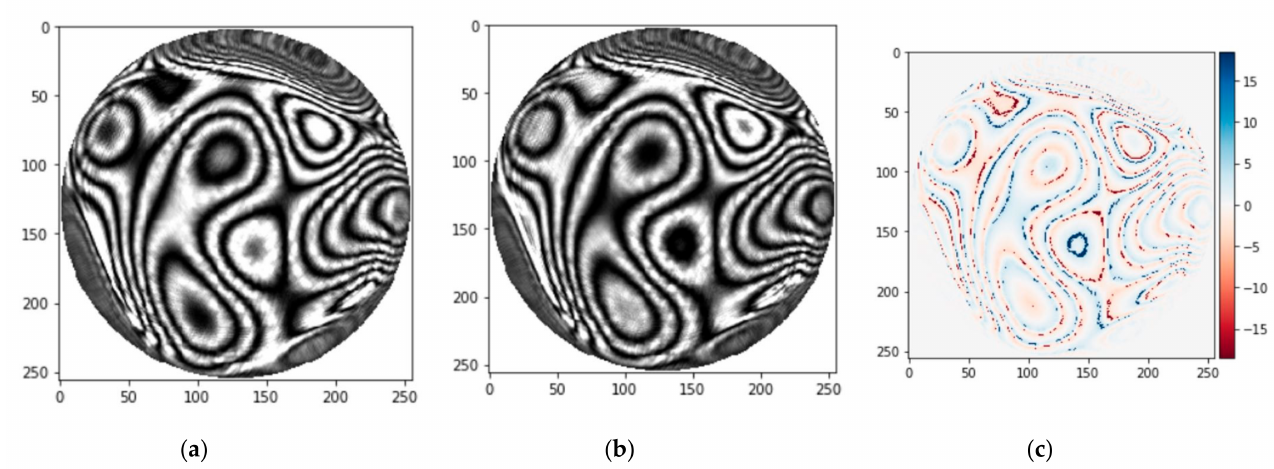
Figure 9. The simulated image of interference fringe. ( a ) The phase shift is zero. ( b ) The phase shift is π /4. ( c ) The input image of the Generator according to Equation (5).